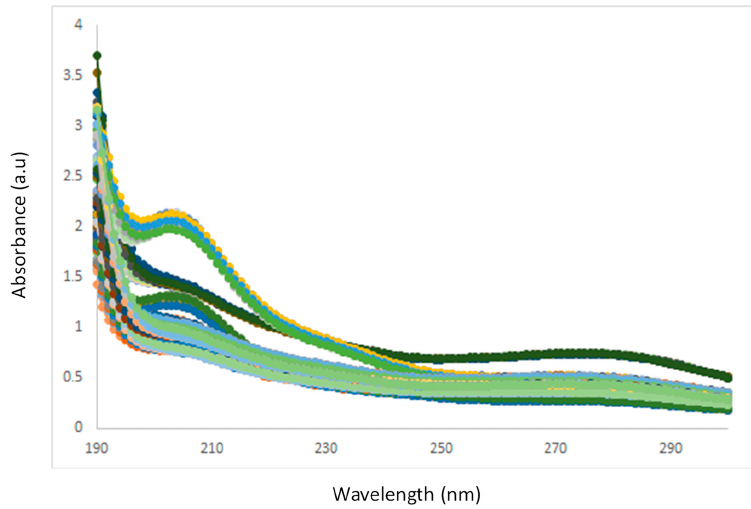
Figure 1. UV-VIS spectra of whisky samples scanned at different temperatures (25, 35, 45, and 55 °C) in transmission.